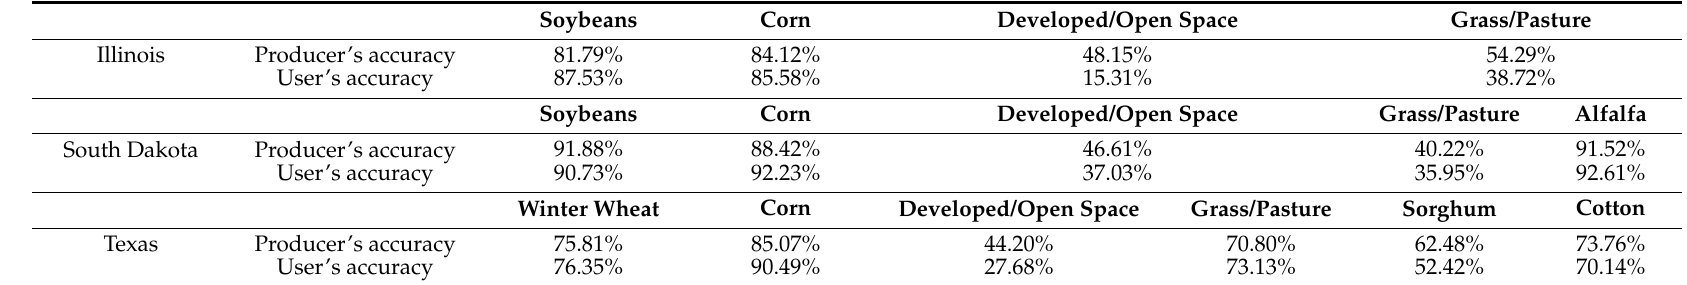
Table 4. Mean producer and user accuracies of classification based on LE-DTW+RF method.